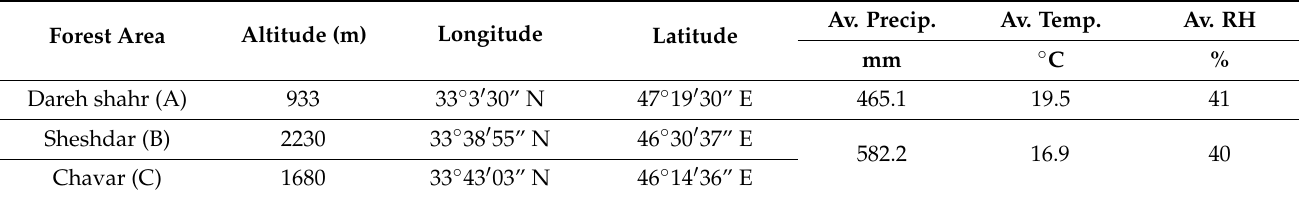
Table 1. Basic characteristics of the Quercus brantii forest sampled for this work. Forest Area Altitude (m) Longitude